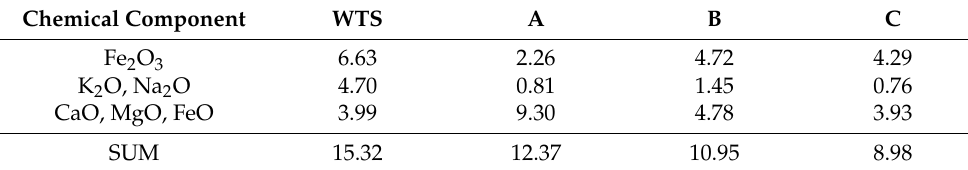
Table 4. The chemical component analysis of fluxing agents (% by